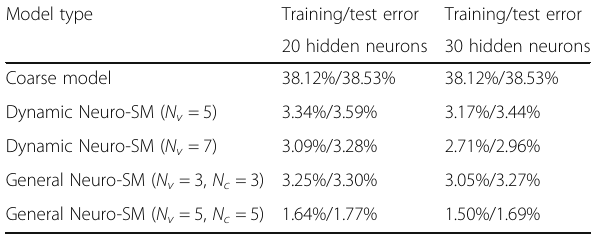
dynamic Neuro-SM model, and the proposed general Neuro-SM model after combined DC, S parameter, and HB